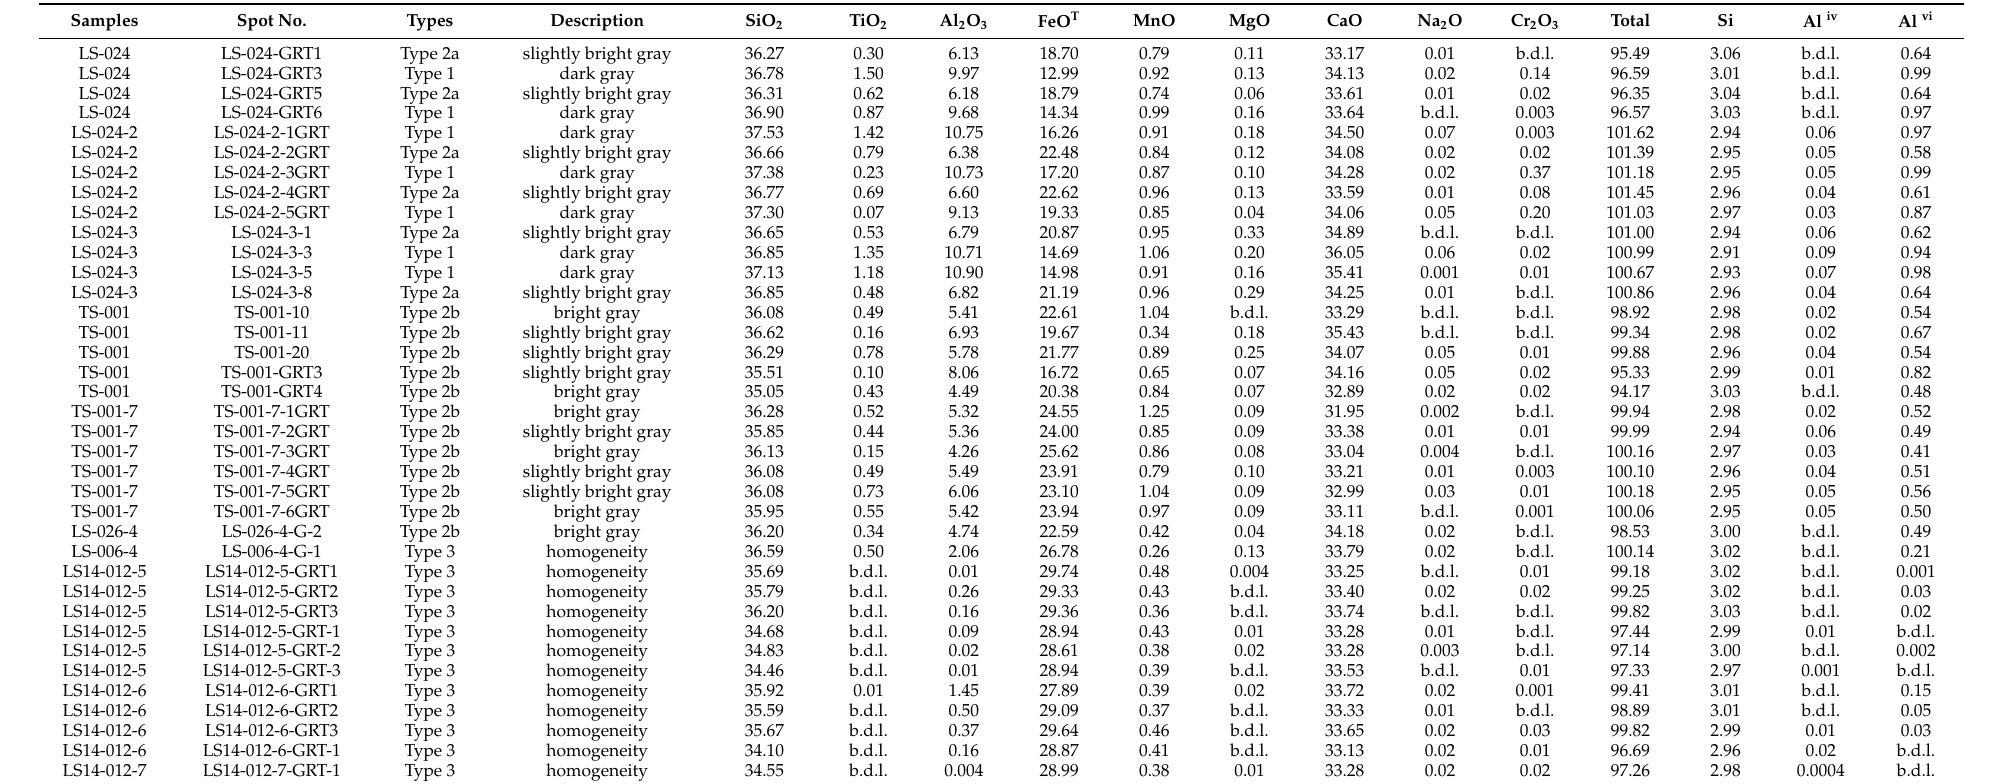
Table 2. EPMA analysis results (wt.%) of garnets from the Laoshankou